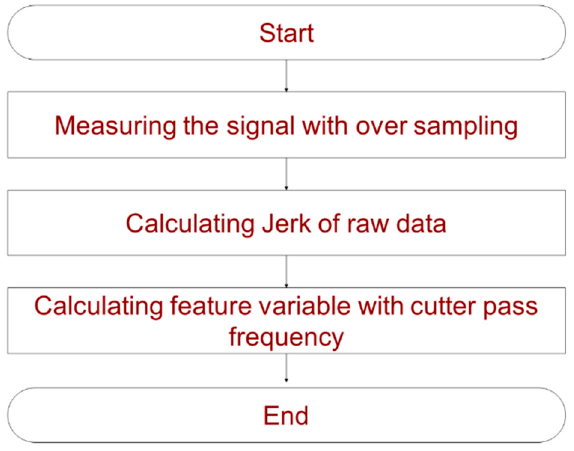
Figure 2. Proposed algorithm for feature variables.